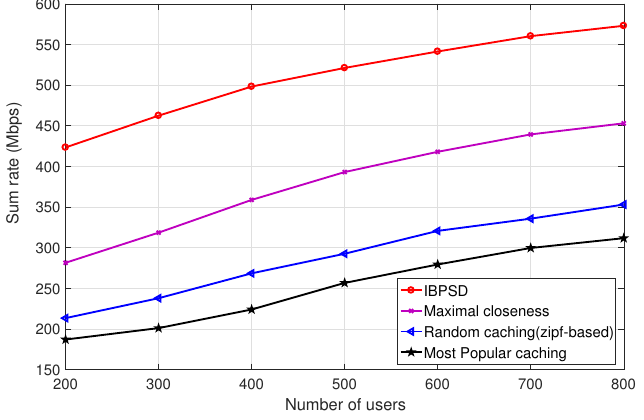
Figure 8. Sum rate vs. number of users.